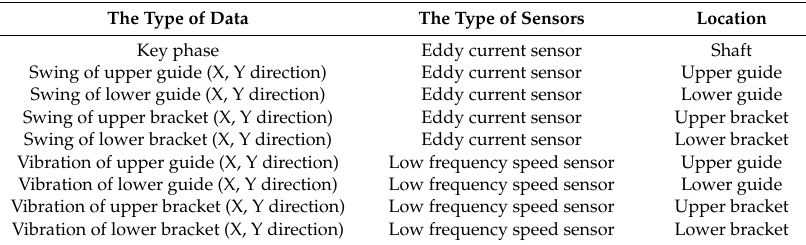
Table 1. The data monitored from TN8000